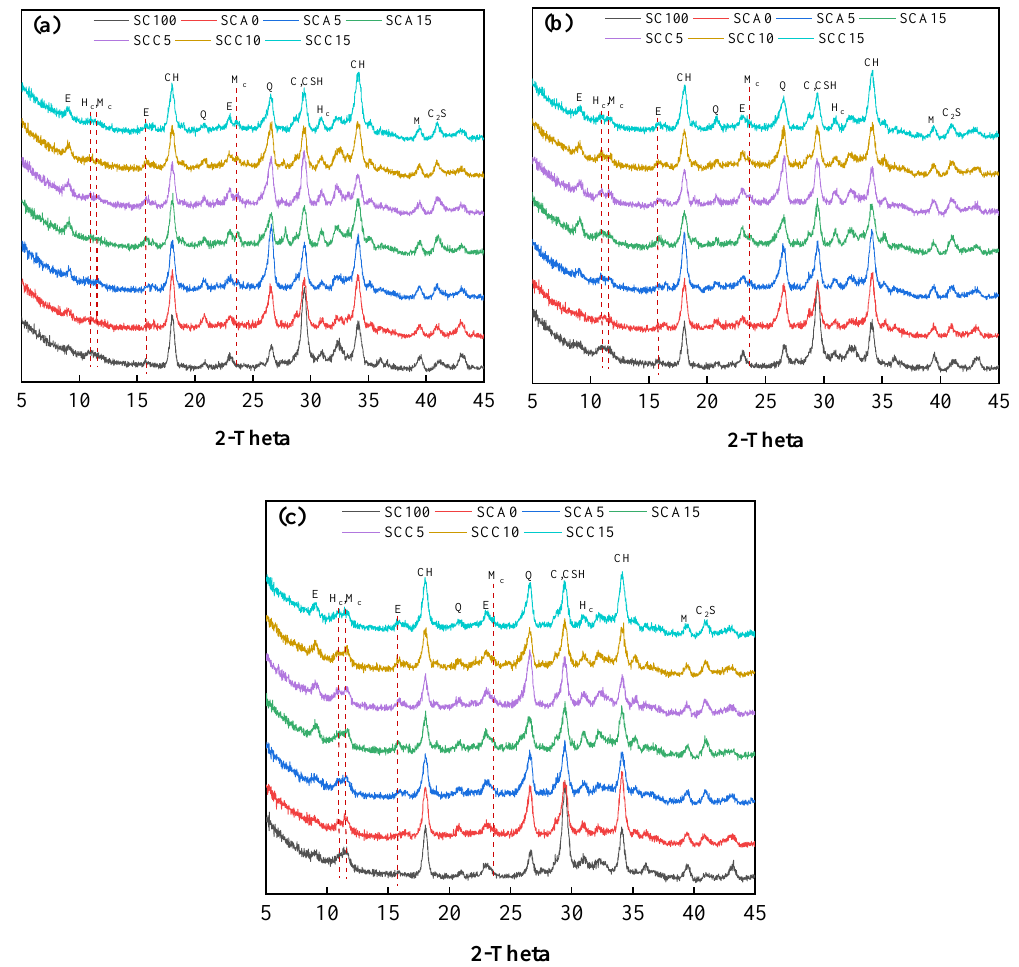
Figure 10. XRD patterns of binder pastes at hydration times of ( a ) 3 days, ( b ) 7 days, and ( c ) 28 days. (E = ettringite, H c = hemicarbonaluminate, M c = monocarbonaluminate, CH = portlandite, Q = quartz, C = Calcite, M = mullite, C 2 S = dicalcium silicate).